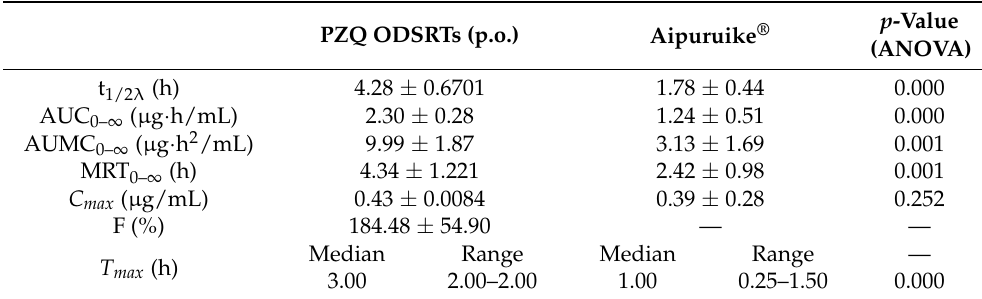
Figure 8. Concentration-time profiles (plasma) of praziquantel following a single p.o. administration of the PZQ ODESRTs and marketed Aipuruike ® at a dose of 5 mg/kg body mass (mean ± SD, n = 9). Table 2. Pharmacokinetic parameters of praziquantel following a single p.o. administration of PZQ ODSRTs and Aipuruike ® at a dose of 5 mg/kg body mass (mean ± SD, n = 9). PZQ ODSRTs